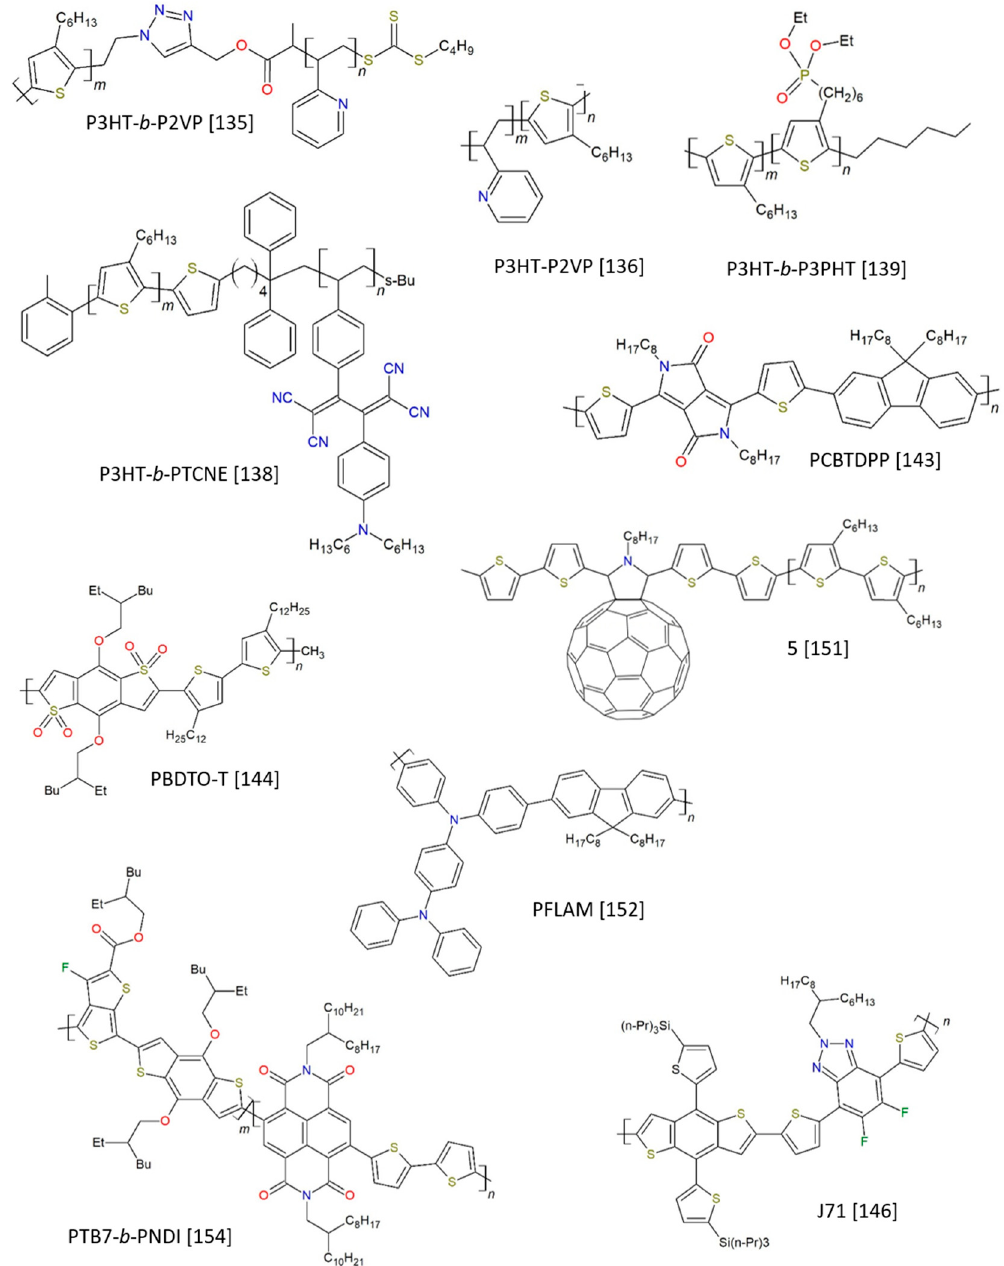
Figure 4. A pictorial collection of the most representative polymeric CBs described in the subsequent sections. CBs are named according to the label provided by the authors in the cited article.